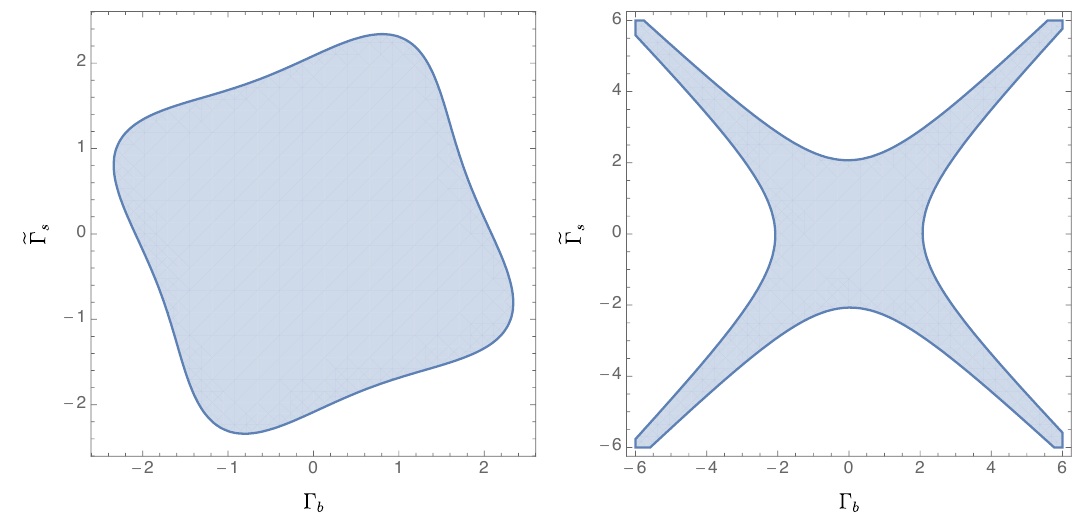
Figure 4 . Allowed region (shaded) in the e (cid:0) s vs (cid:0) b plane at 2 (cid:27) in the two scalar model from B s (cid:0) (cid:22) B s mixing. Left panel: using eq. (4.7), taking m (cid:8) = 100 GeV, m (cid:8) = 400 GeV, and m (cid:9) = 2 TeV, L H Q and V D (cid:3) = (cid:0) V D = 0 : 042. Right panel: the equal mass limit at m (cid:8) = m (cid:8) = 200 GeV, with 3 s 2 b L H m (cid:9) = 2 TeV and V D (cid:3) = (cid:0) V D = 0 : 042; the absence of a bound in the simultaneous (cid:14)m ! 0 3 s 2 b Q